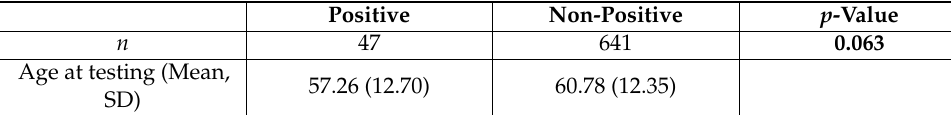
Table 7. Distribution of age at testing across gene panel